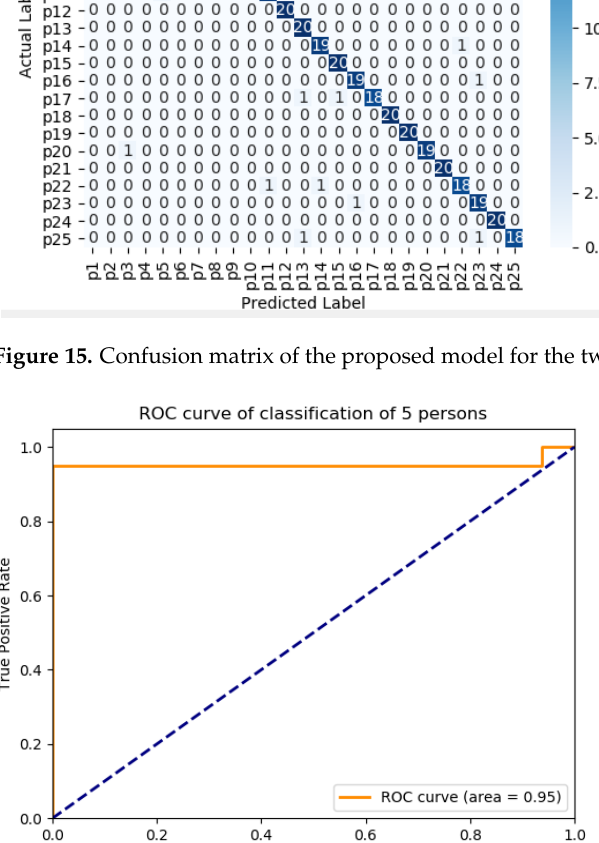
Figure 16. ROC curve of classification of 5 persons.